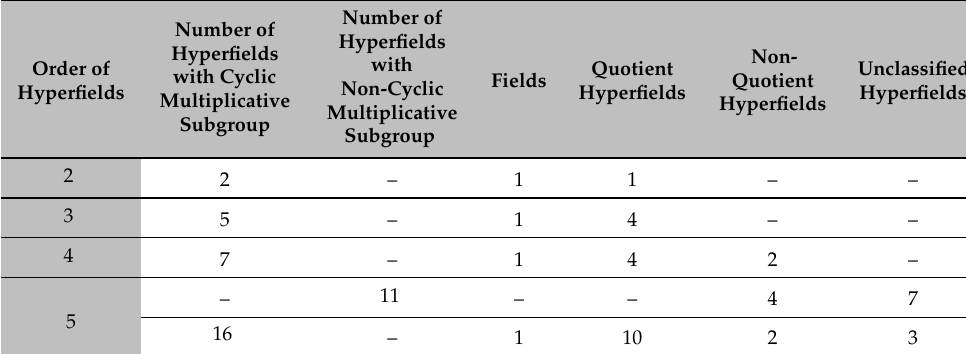
Table 26. Classification of the hyperfields of order